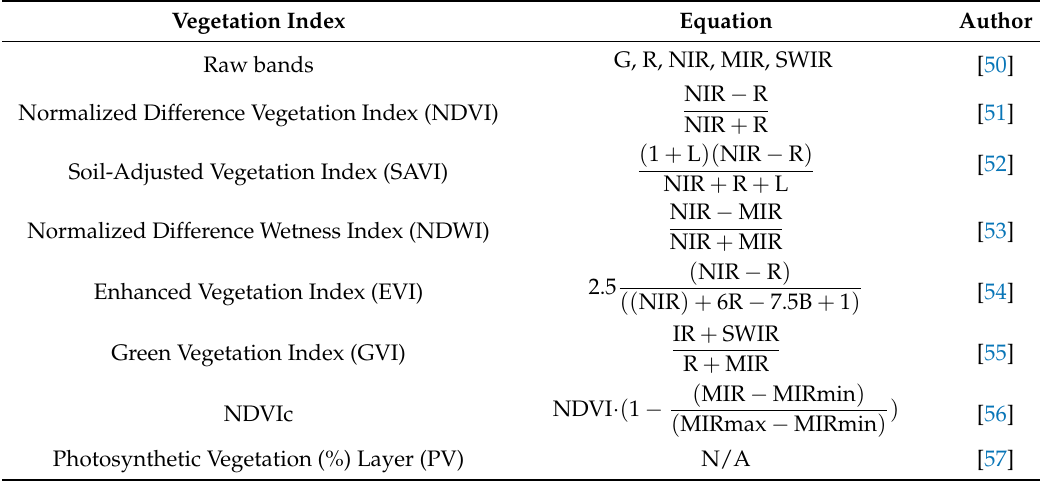
Table 2. Vegetation indices used in this